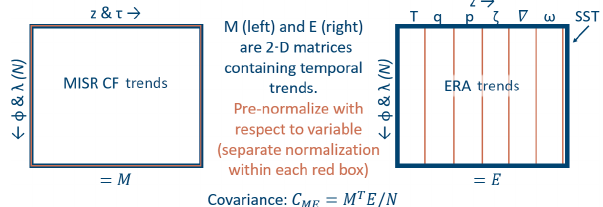
Figure A1. Graphical depiction of how the maximum covariance analysis was formulated. Each of the boxes represents a two- dimensional (2-D) data matrix. The rows of each matrix correspond to latitude and longitude coordinates. Matrix “ M ” contains trends in the MISR cloud fraction joint histogram data. Matrix “ E ” con- tains trends in the ECMWF reanalysis data. The columns of “ M ” represent variability with respect to cloud optical depth and cloud- top height. The columns of “ E ” represent variability with respect to variable type and vertical level. Normalization (subtracting the mean and dividing by the standard deviation) is performed within each red box. C ME is then a covariance matrix that captures spa- tial covariance between the trends in the cloud fraction data and the reanalysis